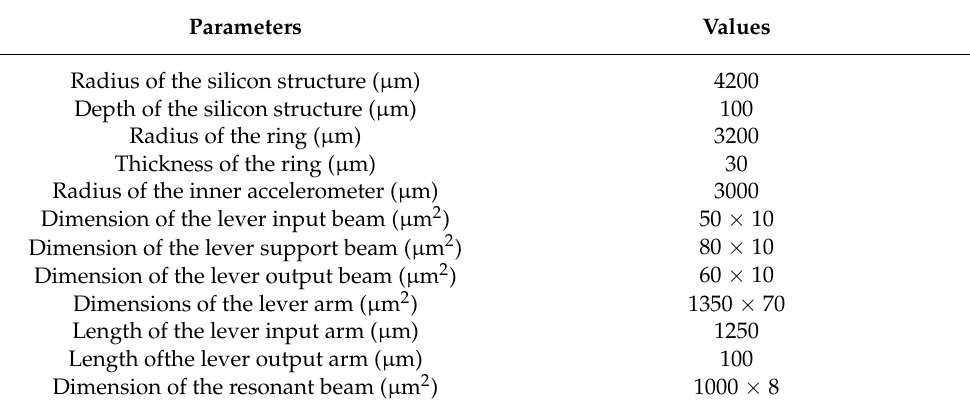
Table 1. The main parameters of the structure. Parameters